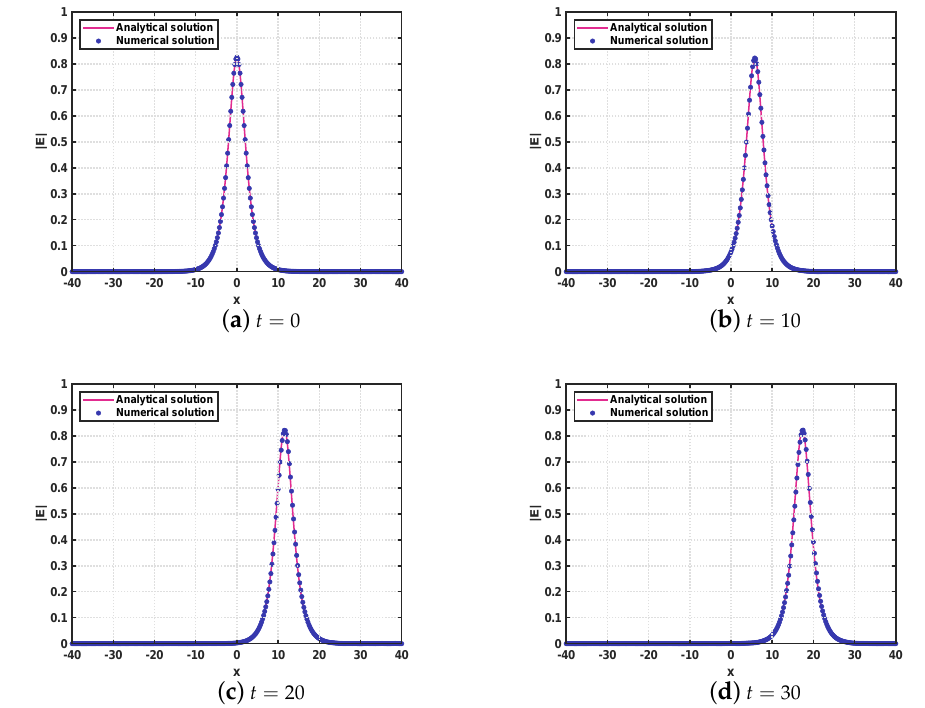
Figure 4. Comparison between numerical solution | E f | ( • ) and analytical solution | E | ( − ) with = 1 τ = τ C and h = 1 at different points in time for Case 2 of Example 4 100 4